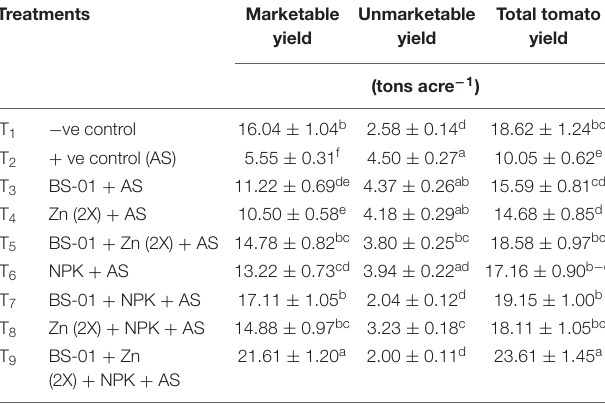
TABLE 6 | Effect of Bacillus subtilis (BS-01) and mineral nutrients [Zn (2X: 10 kg acre − 1 ) and NPK (64:46:50 kg acre − 1 )] on the grading of tomato fruits from the plants inoculated with Alternaria solani (AS) in the field after 90 days of pathogen inoculation (DPI). Treatments Grading percentage of tomato